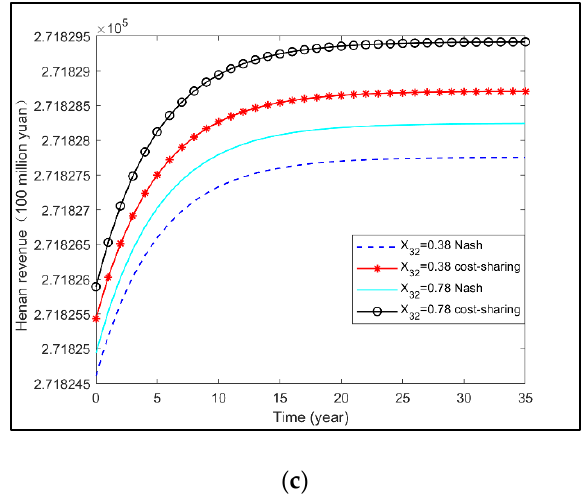
Figure 11. The effects of Shaanxi province’s X 32 on each government’s revenues: ( a ) the Shanxi province government’s revenues, ( b ) the Shaanxi province government’s revenues, and ( c ) the Henan province government’s revenues.